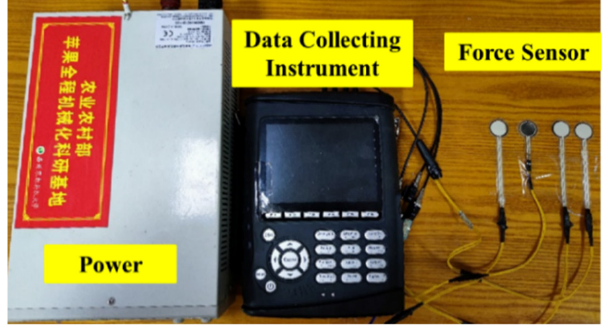
Figure 25. Robotic hydrostatic experiment system.